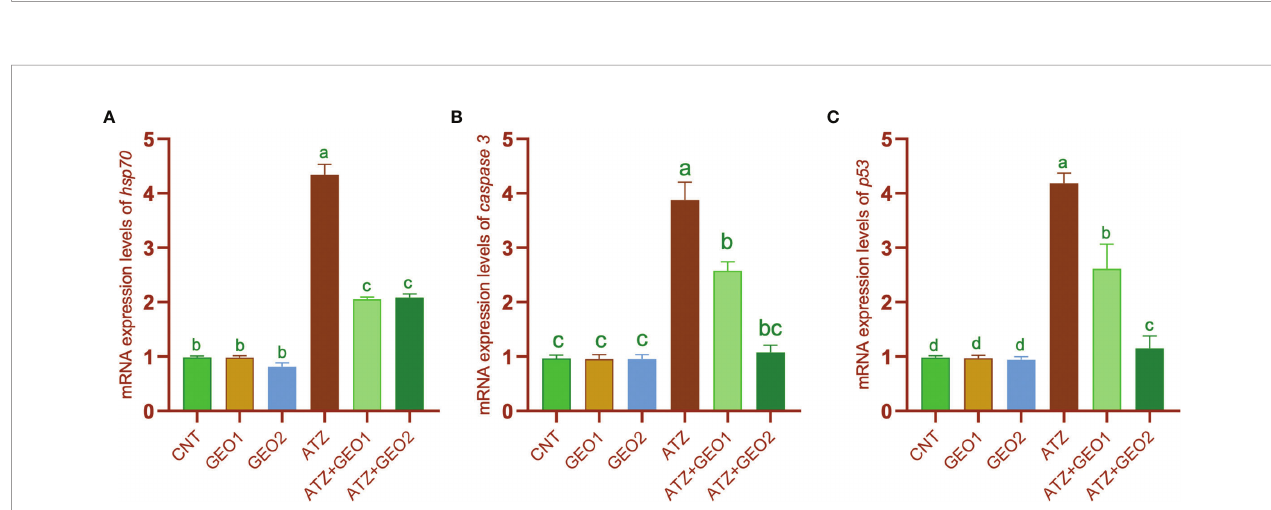
FIGURE 5 | mRNA expression levels of heat shock protein 70 hsp70 (A) , caspase 3 (B) , and tumor suppressor protein p53 (C) genes relative to b -actin gene in the hepatic tissues of Nile tilapia in response to sub-lethal ATZ exposure and/or dietary supplementation with GEO for 60. Values are expressed as means ± S.E.M (n = 9). Values that are not sharing a common letter differ signi fi cantly at P < 0.05.